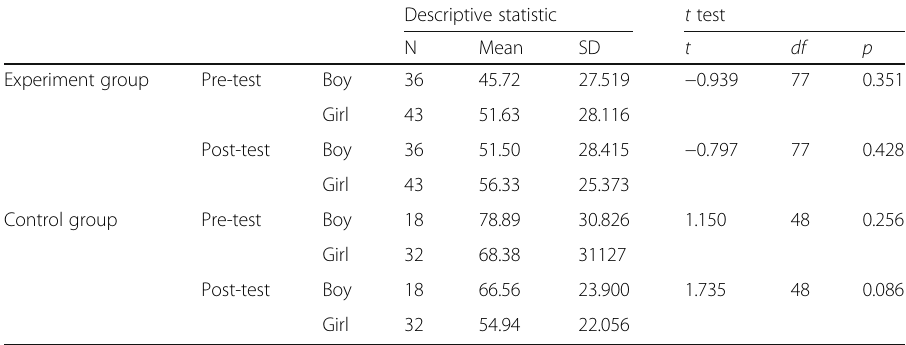
Table 11 Independent t test result for students ’ academic achievements in the experiment and control groups (gender difference